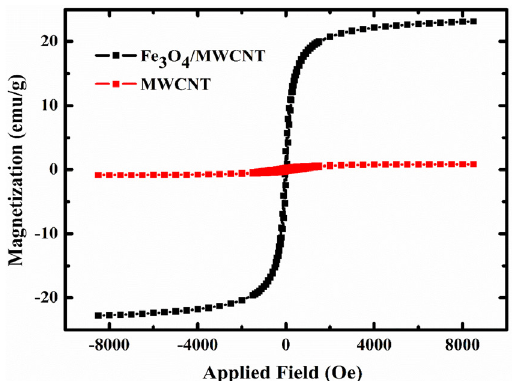
Fig. 4. Hysteresis loops of Fe